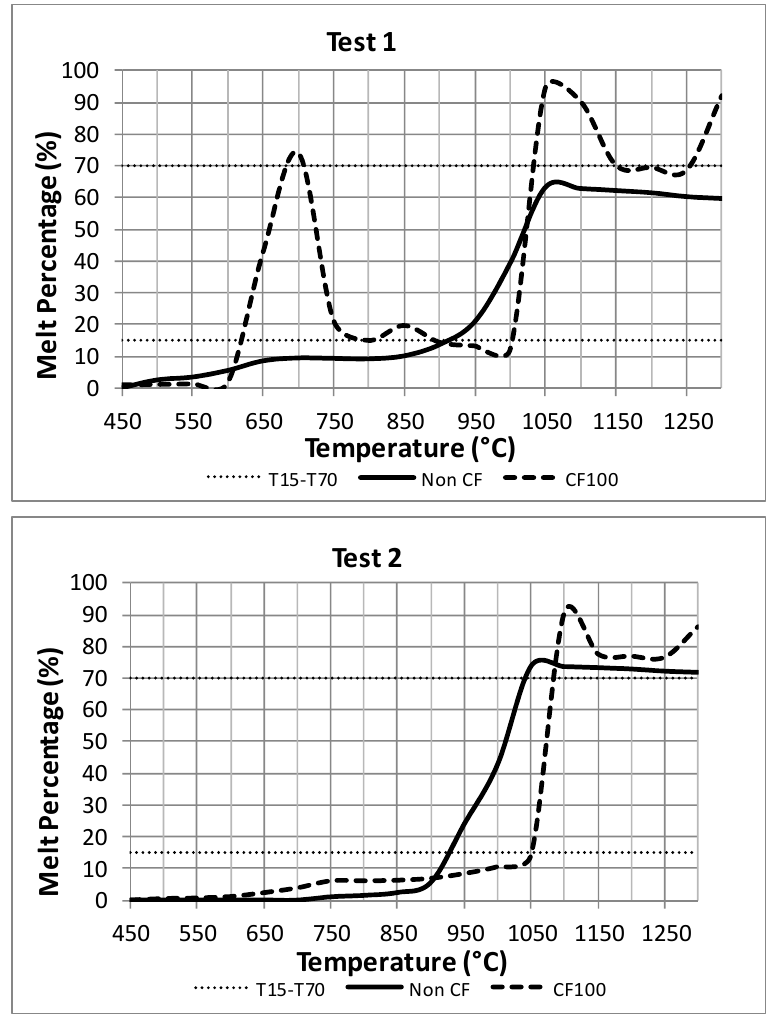
Figure 8. Ash melting curves obtained for Test 1 ( top ) and Test 2 ( bottom ) disregarding (solid line) and considering (dashed line) chemical fractionation (CF100 case, GE model). Horizontal lines indicate the T 15 and T 70 values, respectively.